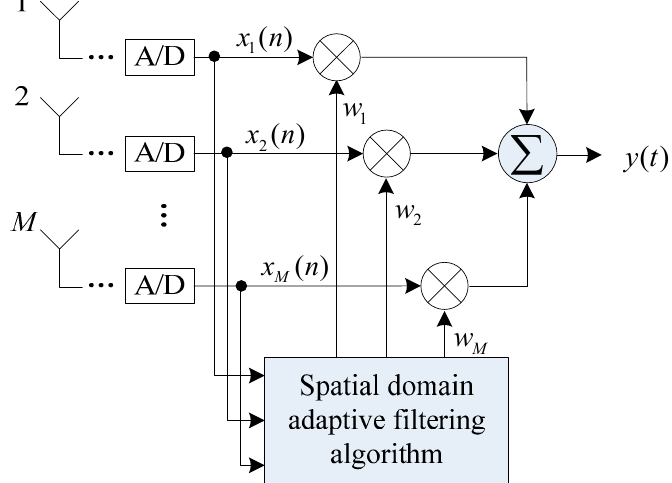
Figure 5. Schematic diagram of the spatial filtering structure based on the antenna array.